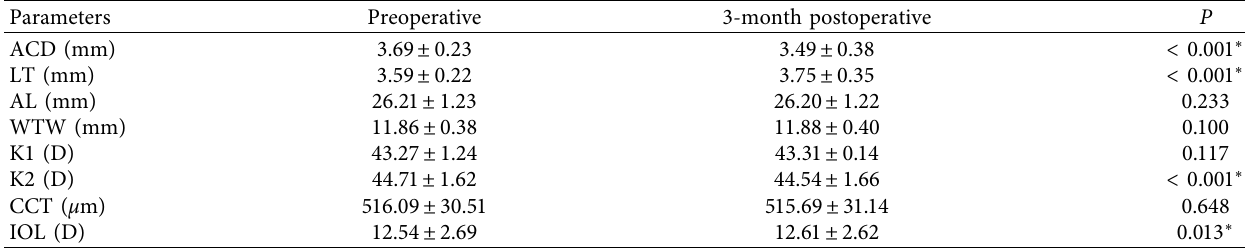
Table 1: The biometric parameters measured by